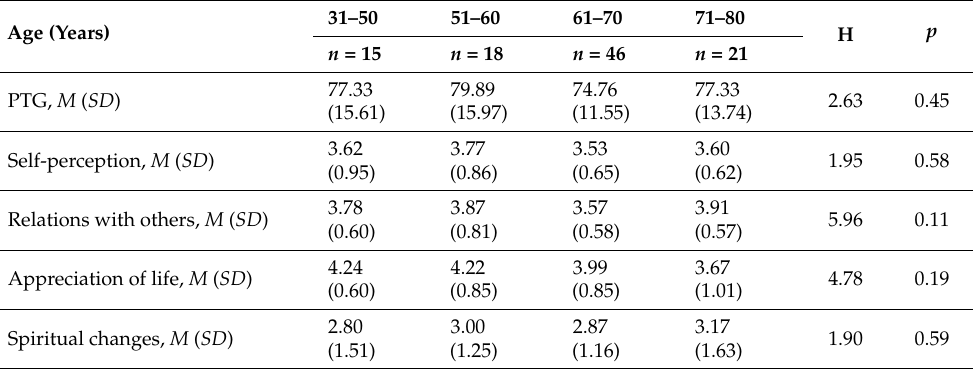
Table 4. Differences in post-traumatic growth and its components in women of different ages (Kruskal–Wallis test).